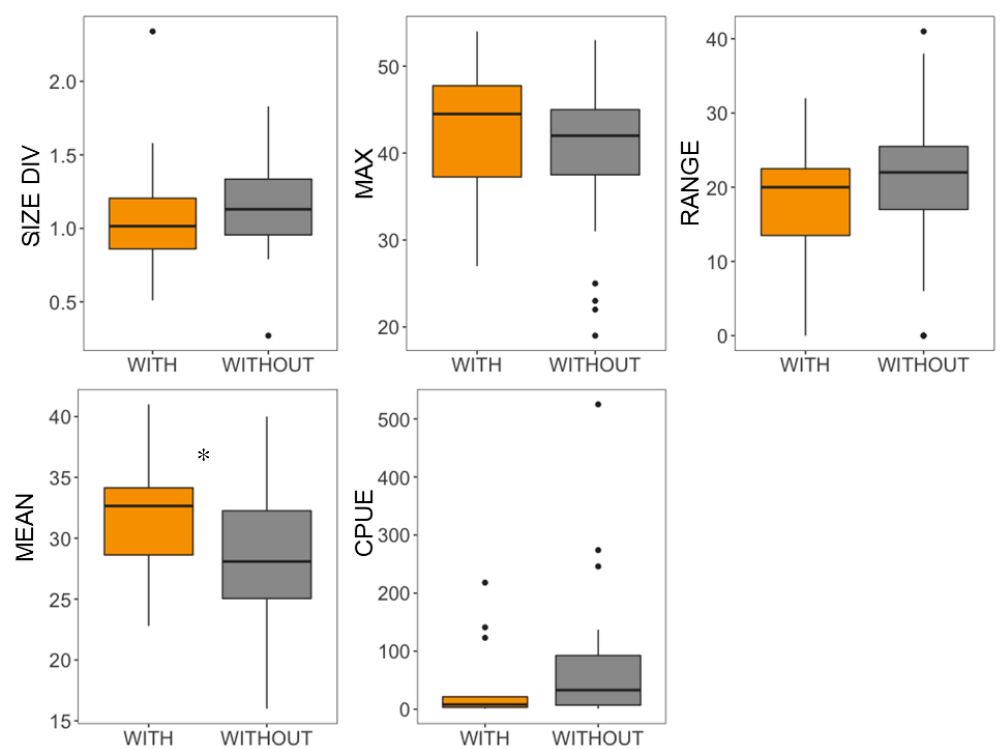
Figure 2. Boxplots showing the distribution of Aphanius iberus capture per unit of effort (CPUE) and size-related variables according to the presence (“with Gambusia”) or absence (“without Gambusia”) of Gambusia holbrooki . Significant differences are marked with the asterisk symbol (*).